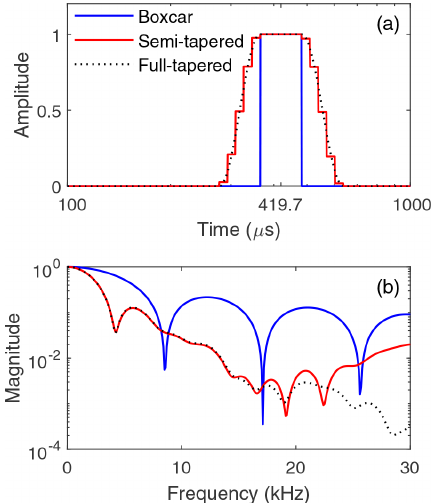
Figure 2. Comparison of boxcar, full-tapered, and semi-tapered gates in the time domain (a) and frequency domain (b) . The gate center time is 419.7µs. The boxcar gate width is 114.6µs and the semi-tapered width is 235.5µs (gate 17 in Table